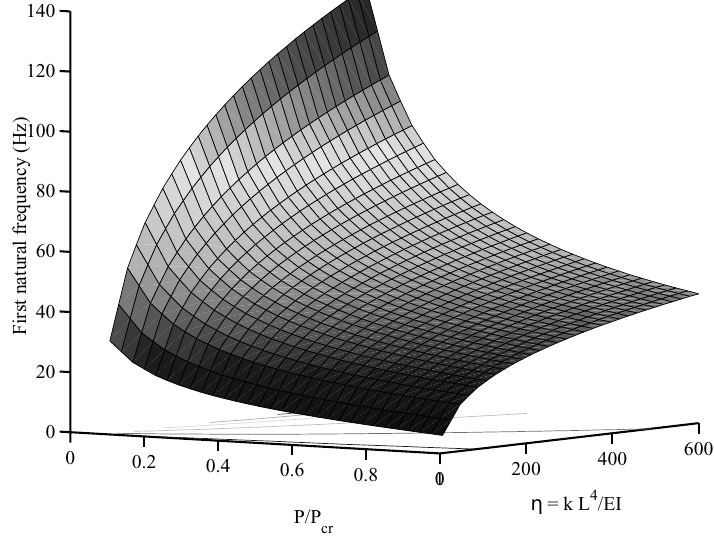
Fig. 13. Variation of the first natural frequency of the cantilever pile with respect to the normalized support stiffness and axial load. nondimensional height ( φ h ). The shape parameters take account of the physical shape of the building so that it is not considered as a point mass used in many simplified